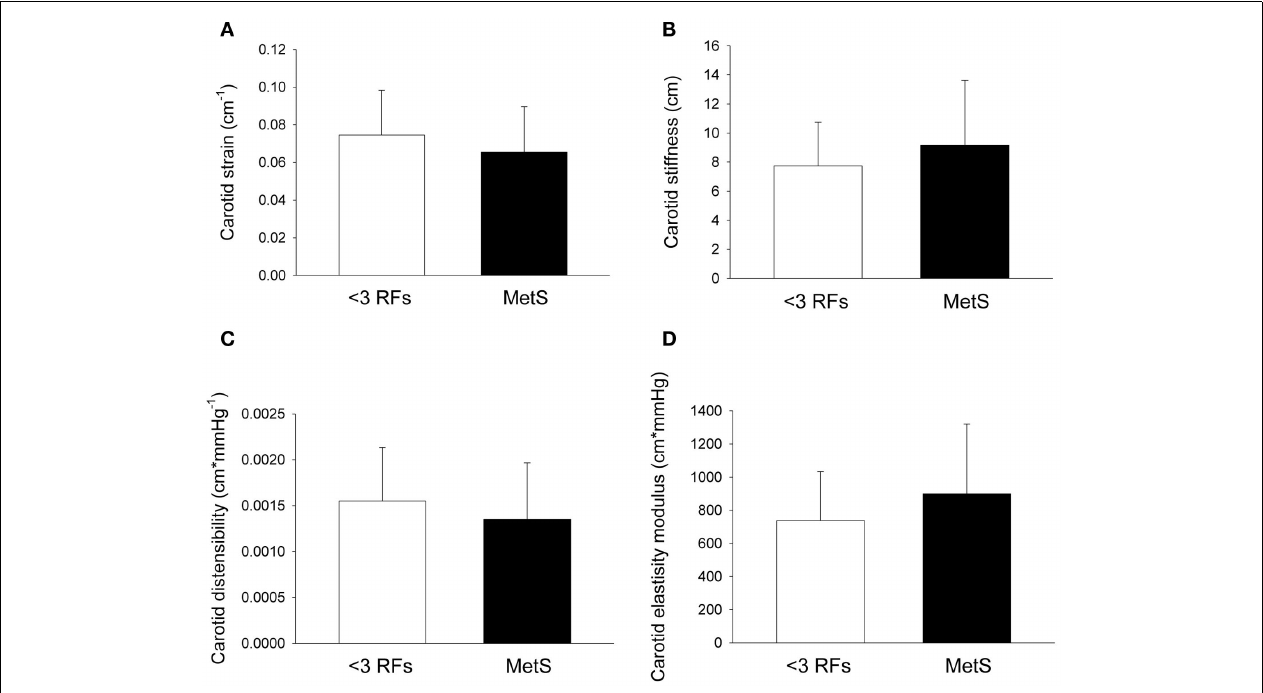
of anti-hypertension medication on carotid stiffness (see Table 4 ).There was a significant effect of anti-hypertension medication use on carotid distensibility (see Table 4 ).Values are mean ± SD. Corresponding SE values are (A) 0.005cm − 1 ( < 3 RFs) and 0.004cm − 1 (MetS); (B) 0.6cm ( < 3 RFs) and 0.07cm (MetS); (C) 0.0001cm*mmHg − 1 ( < 3 RFs) and 0.0001cm*mmHg − 1 (MetS); (D) 57cm*mmHg ( < 3 RFs) and 67cm*mmHg